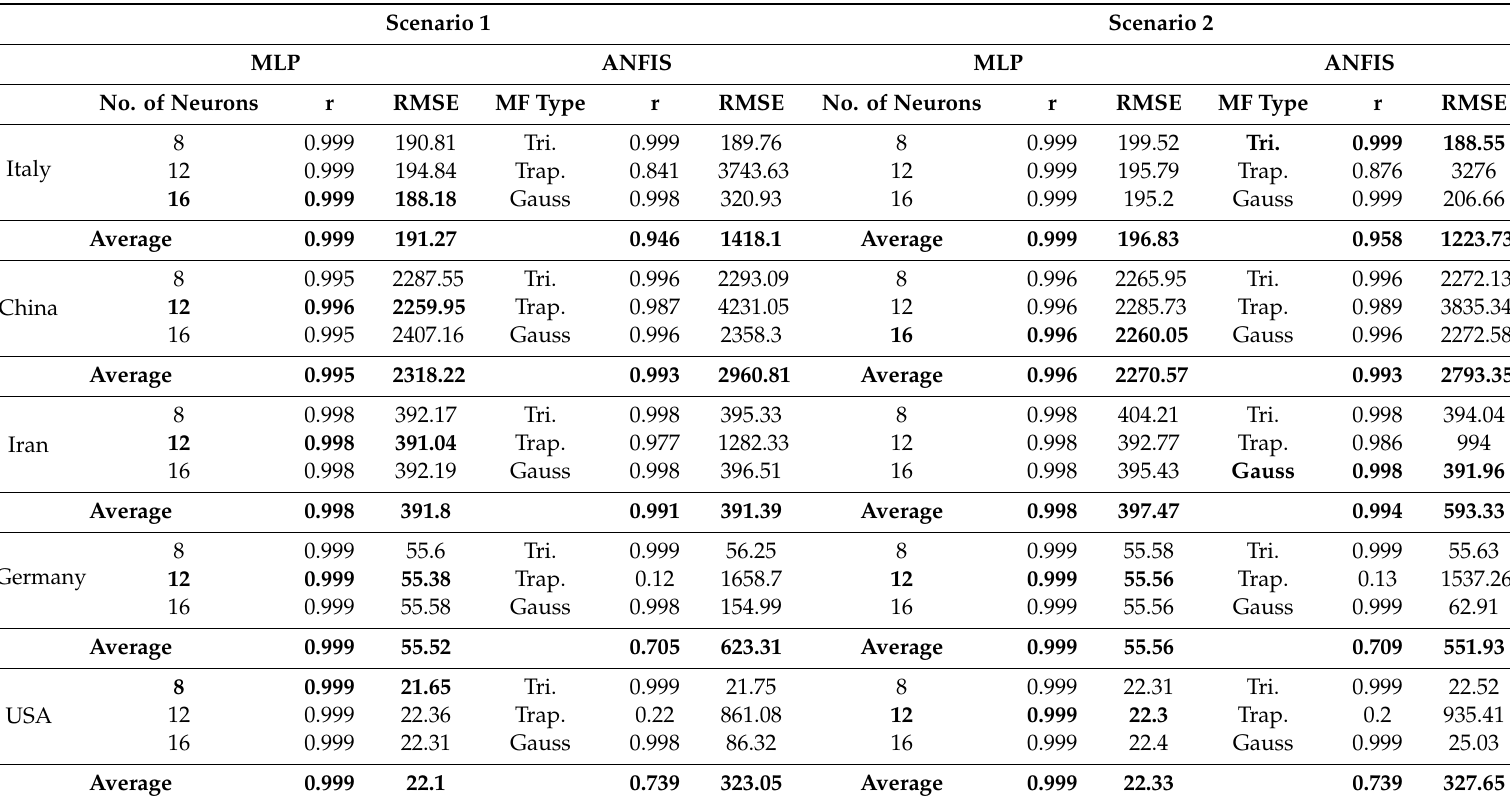
Table 16. Results for the training phase of the ML